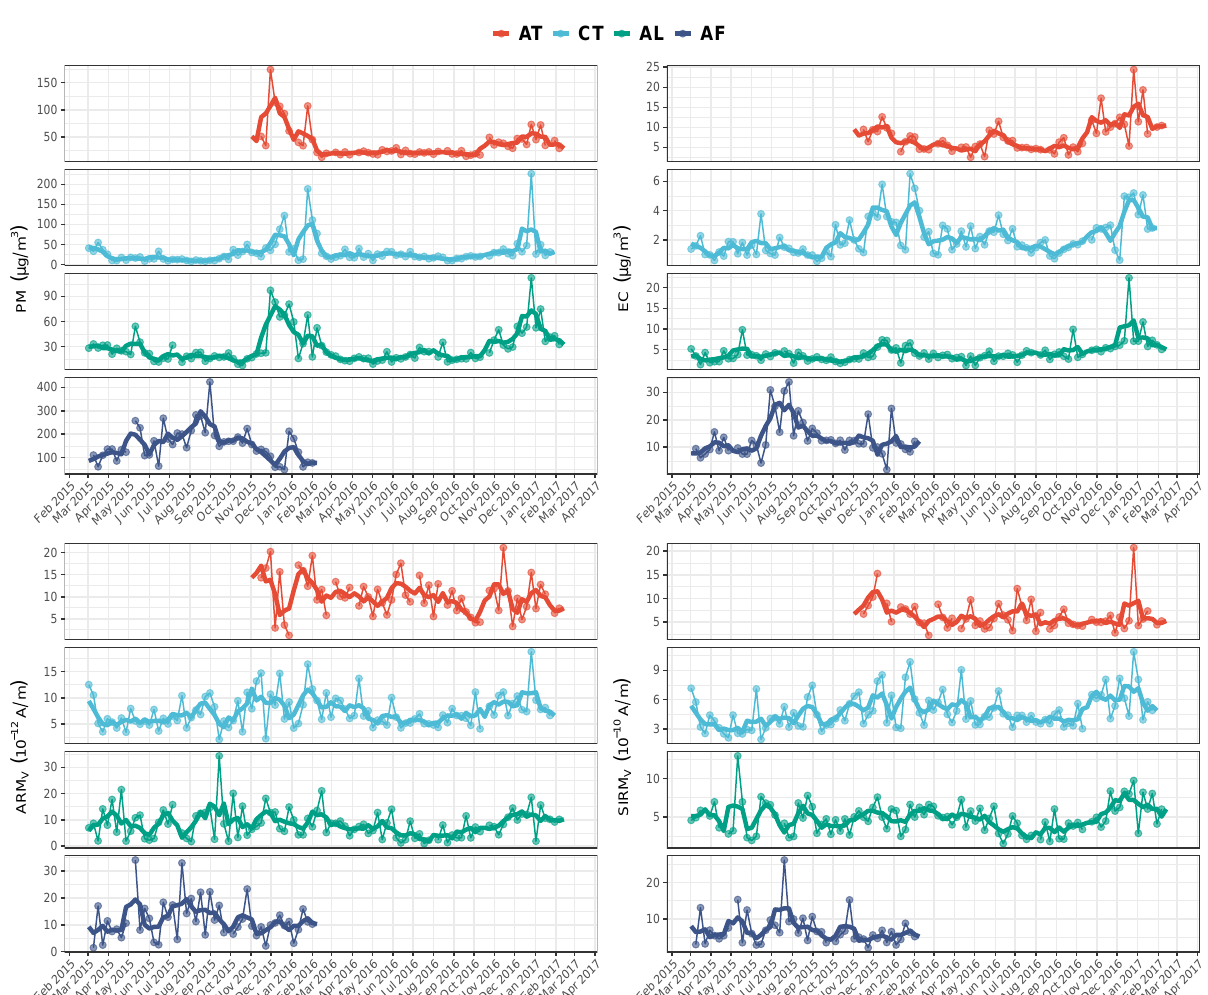
Figure 4. Concentration parameters PM2.5, EC, ARM V (anhysteretic remanent magnetization volume normalized) and SIRM V . The lines are the monthly running means and points the individual weekly